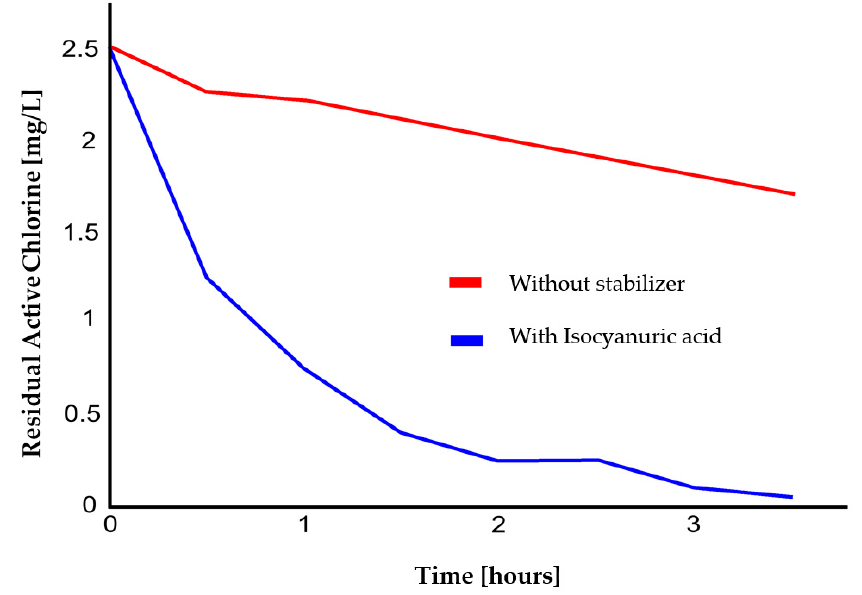
Figure 1. Comparison of residual active chlorine levels vs. the use of stabilizers (or lack thereof)